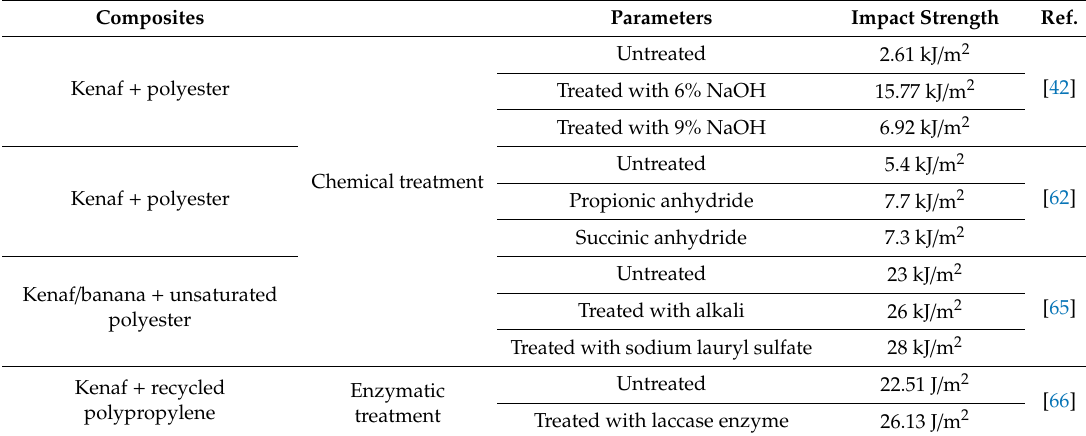
Table 5. Previous studies on di ff erent kenaf fibre